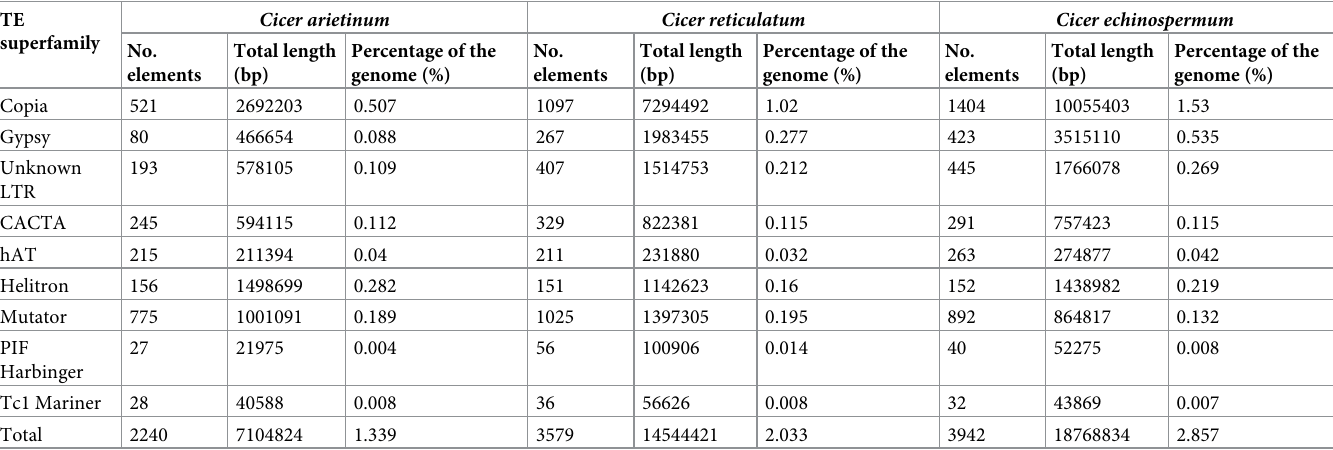
Table 1. Summary of the intact TEs identified in Cicer